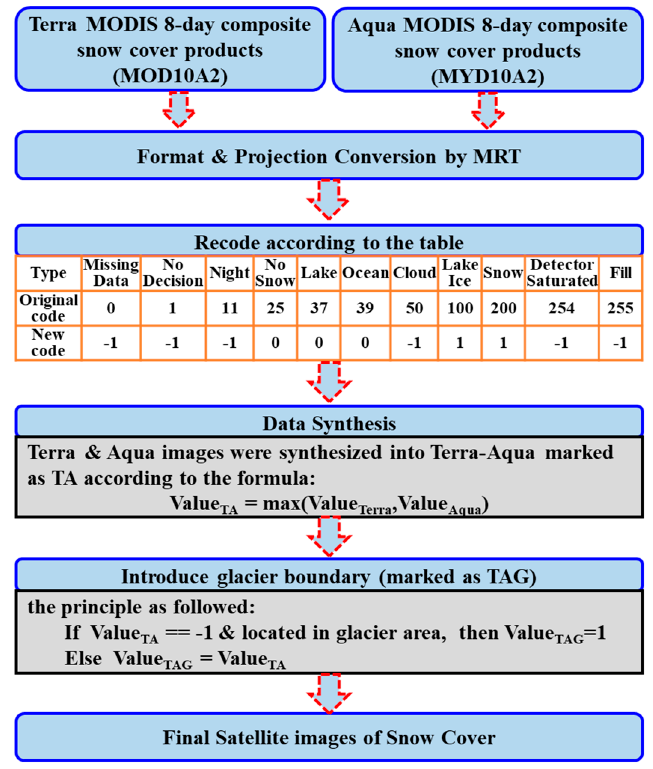
Figure 4. Flowchart of eliminating cloud pixels in snow-cover images.